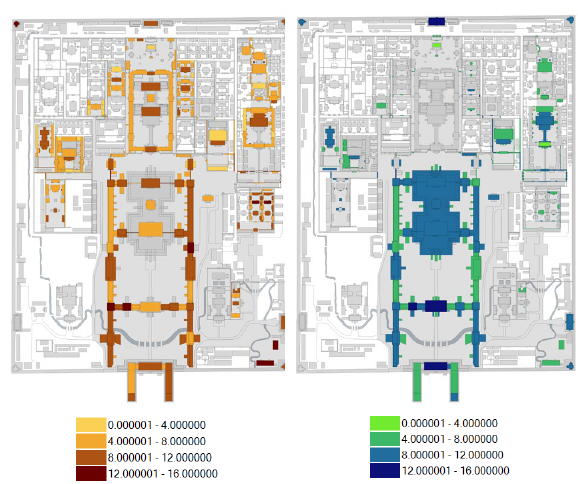
Figure 6. The overall deterioration condition of brick (left) and stone